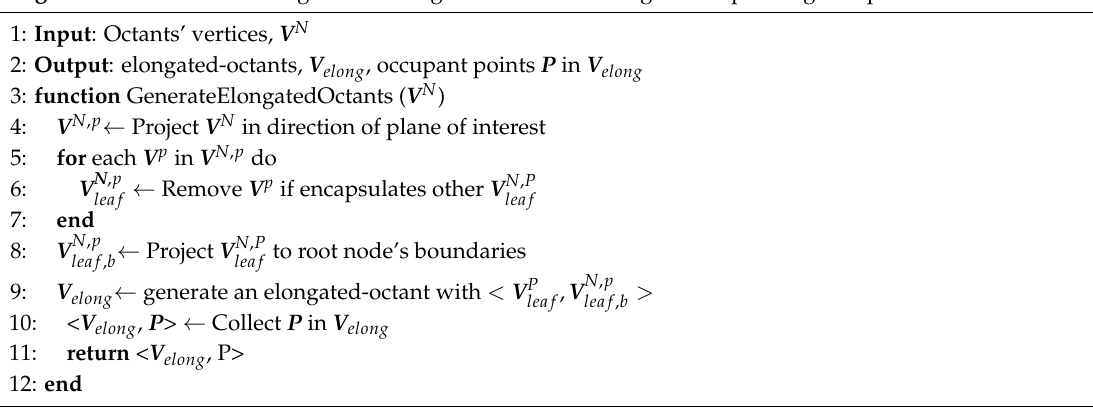
Figure 10. Sequence of steps to generated elongated octants. ( a ) A sample Octree; ( b ) projected vertices to a horizontal plane; ( c ) elongated octants. Algorithm 1 Pseudocode to generate elongated-octant and assign corresponding occupants